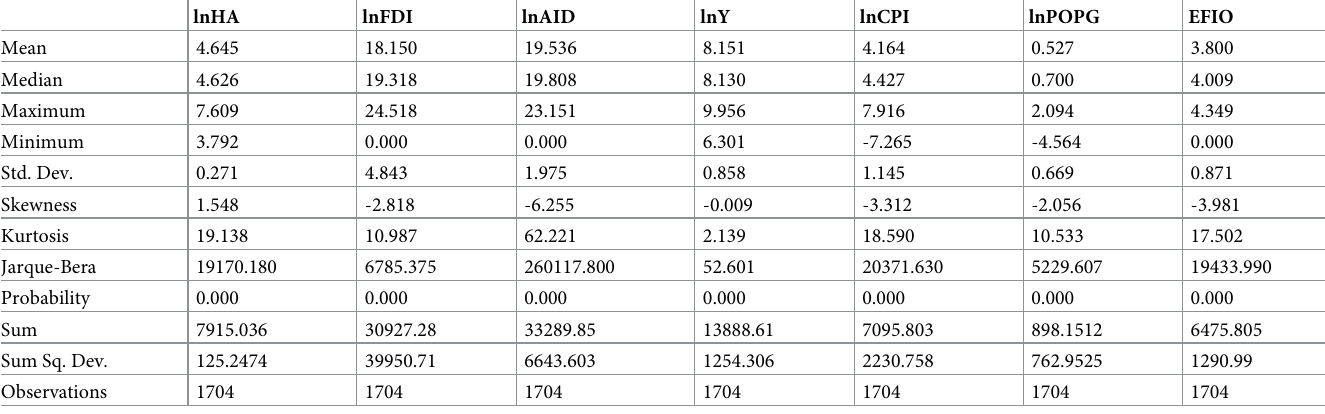
Table 2. Descriptive